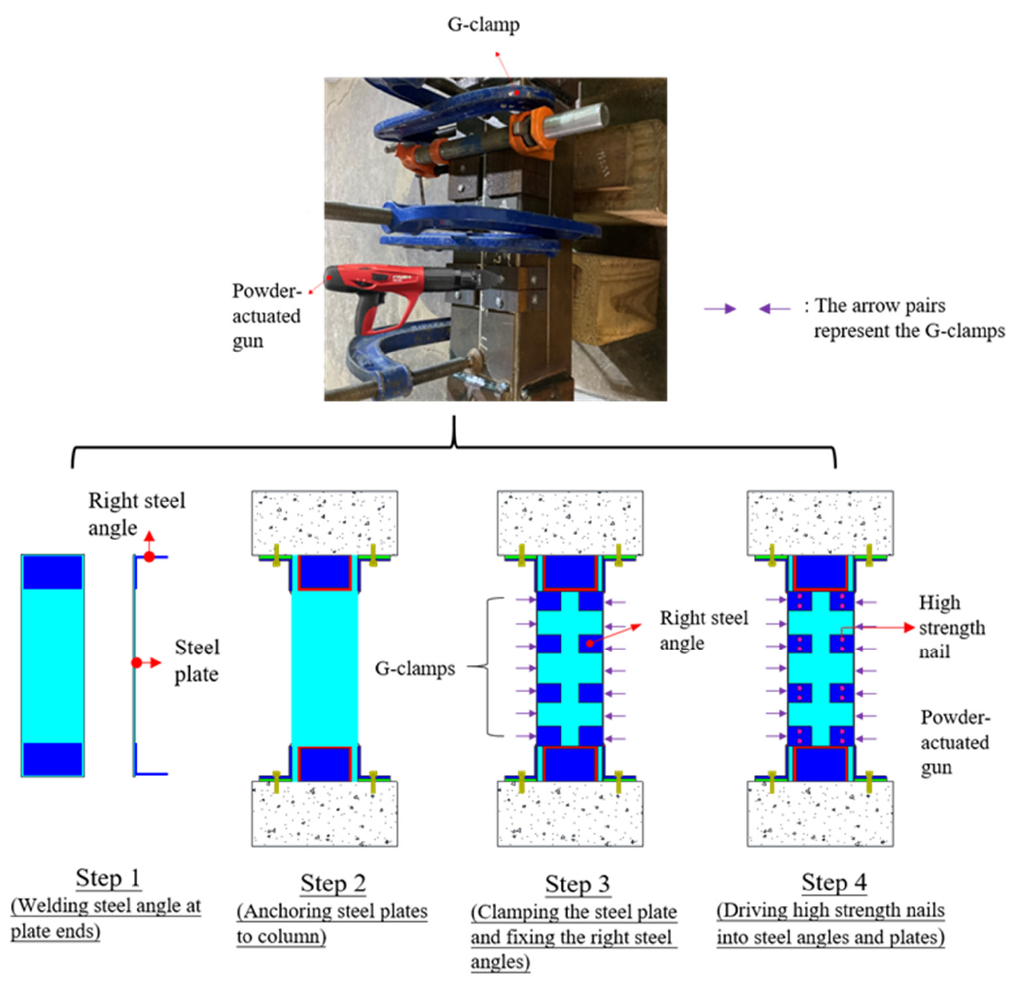
Figure 3. Strengthening procedure.